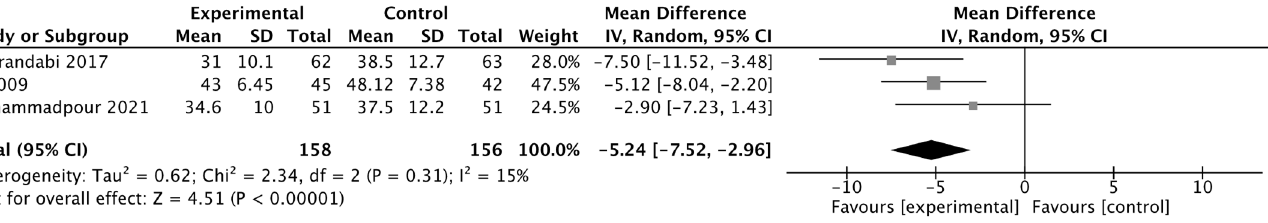
Figure 6. State anxiety forest plot [38,43,46].